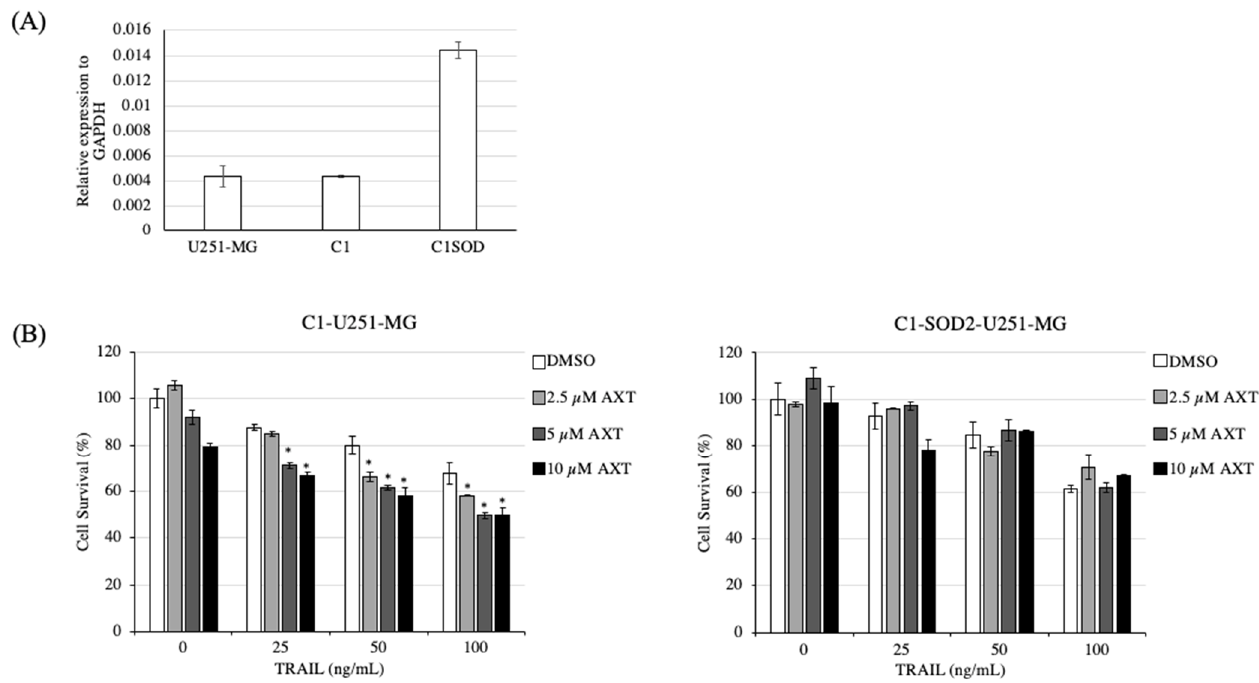
Figure 7. Transient SOD2 overexpression in U251-MG abolished AXT sensitization to TRAIL treat- ment. ( A ) U251-MG cells were transfected with C1-SOD2-GFP plasmid or C1-GFP plasmid, and SOD2 expression was analyzed by RT-qPCR to monitor transfection efficiency. ( B ) C1-U251-MG (control) and C1-SOD2-U251-MG were plated for treatment with AXT and TRAIL at conditions as described above. Experiments were performed in three independent replicas, and representative figures are presented for both cell lines. Cells survivals were presented as means and SD with DMSO-treated cells as control (100% survival). * p < 0.05, significantly different from the DMSO group (Dunnett’s test).